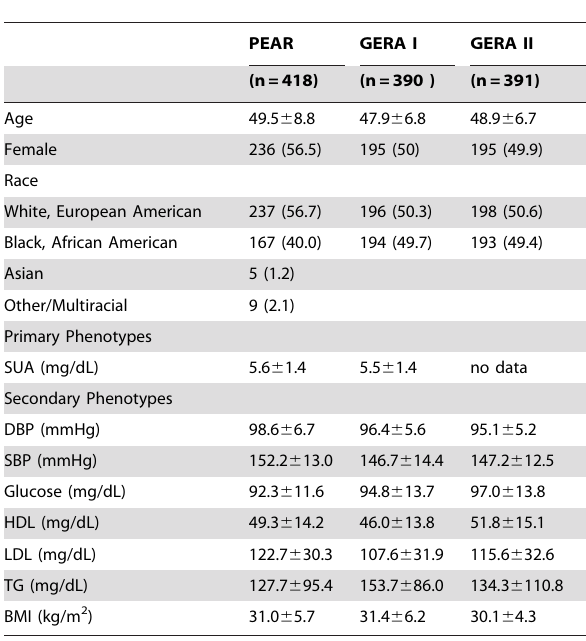
Table 1. Baseline characteristics of study populations.